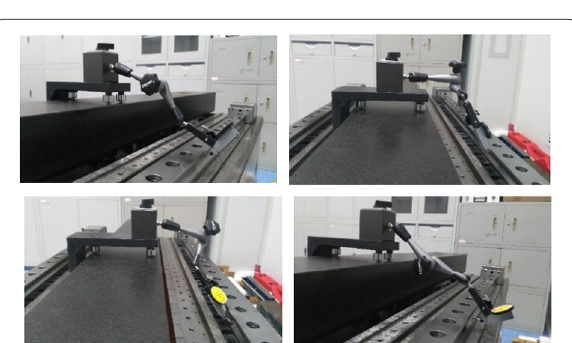
Figure 16 Straightness errors measurement on the surfaces of the rolling